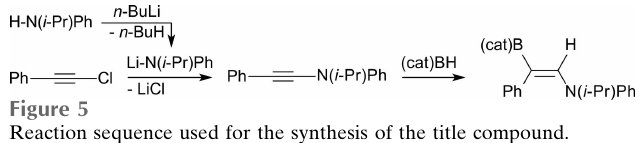
Figure 5 Reaction sequence used for the synthesis of the title